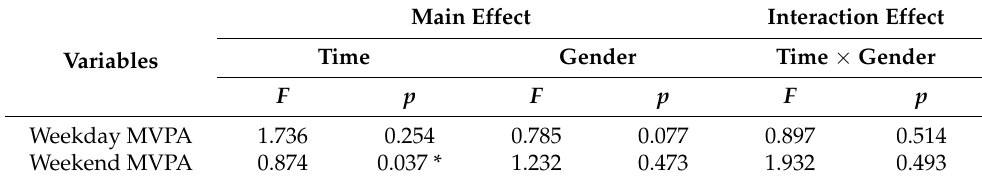
Table 4. ANOVA of time, gender, and physical activity